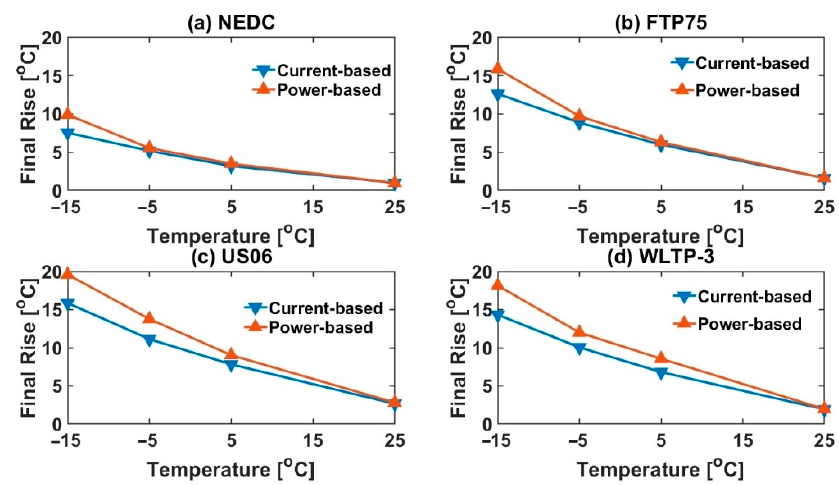
Figure 12. Final operating temperature rise for both current-based and power-based profiles for different drive cycles at various ambient temperatures for 2nd order ECM: ( a ) NEDC, ( b ) FTP75, ( c ) US06 and ( d ) WLTP-3.